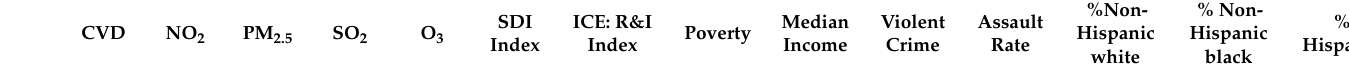
CVD NO 2 PM 2.5 SO 2 O 3